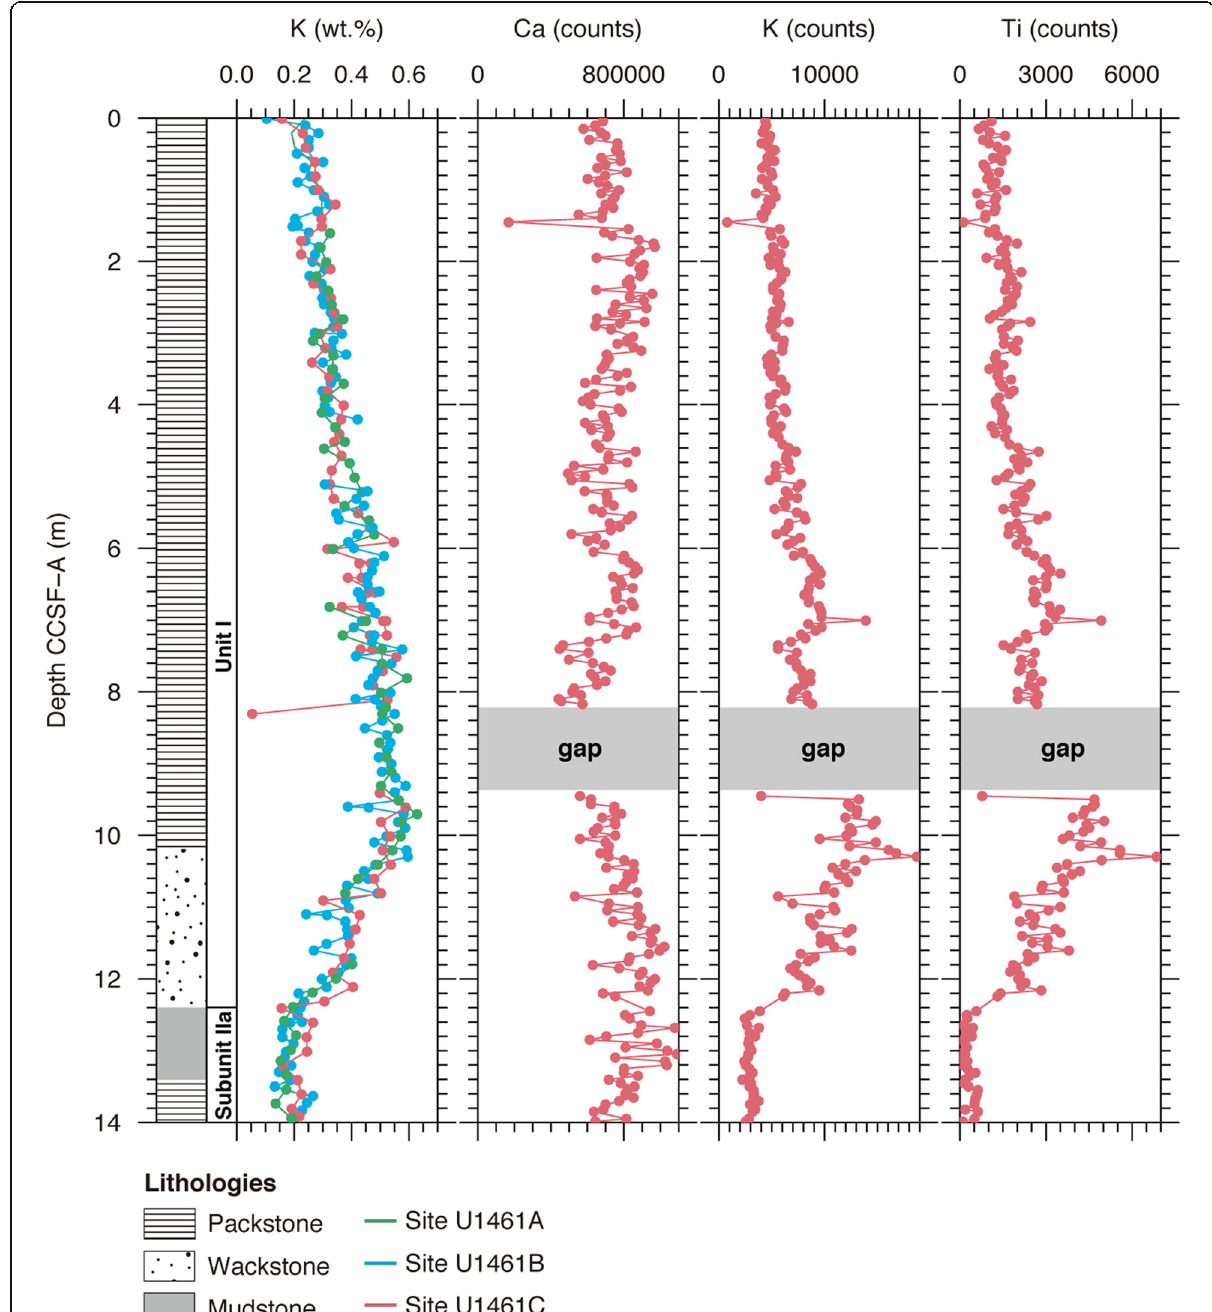
Fig. 2 Lithology, %K, and major elemental (Ca, K, and Ti) variation at Site U1461 for the top 1400cm. The shipboard analysis generated the lithology, units, and bulk mineralogy. The %K contents were obtained from a shipboard NGR analysis and the MATLAB code from De Vleeschouwer et al. (2017). The major elemental analysis (Ca, K, and Ti) on Hole C sediments was conducted by XRF scanning at the IODP Texas Gulf